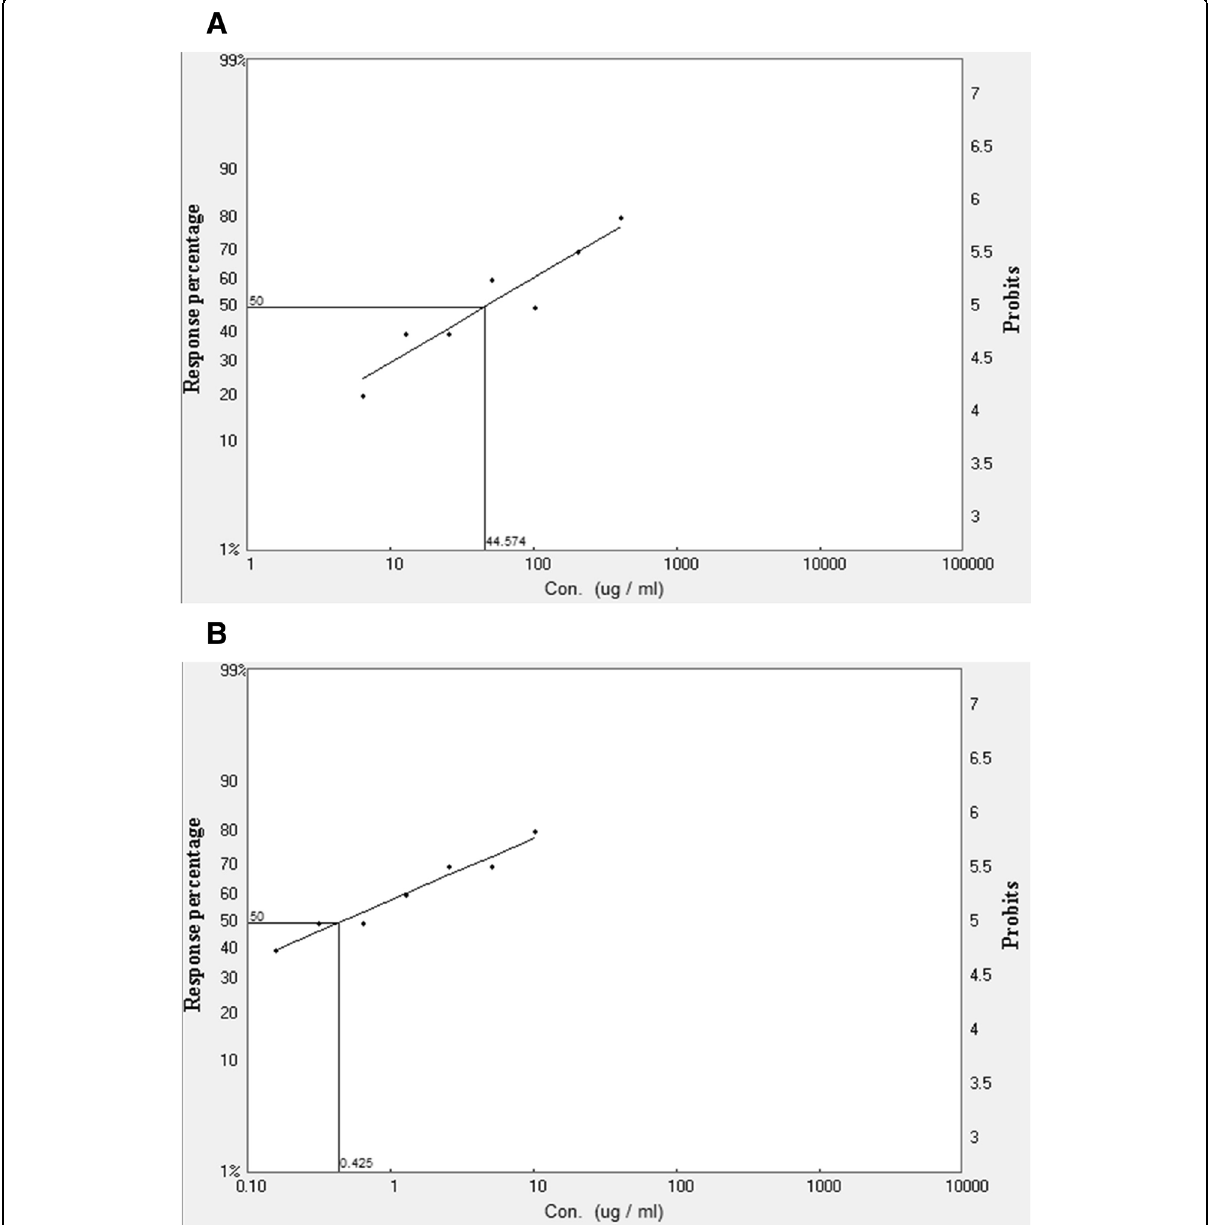
Fig. 4 a , b Determination of LC 50 for the ethanolic extract of A. ilicifolius L. a and vincristine sulphate ( b ) using Ldp line software